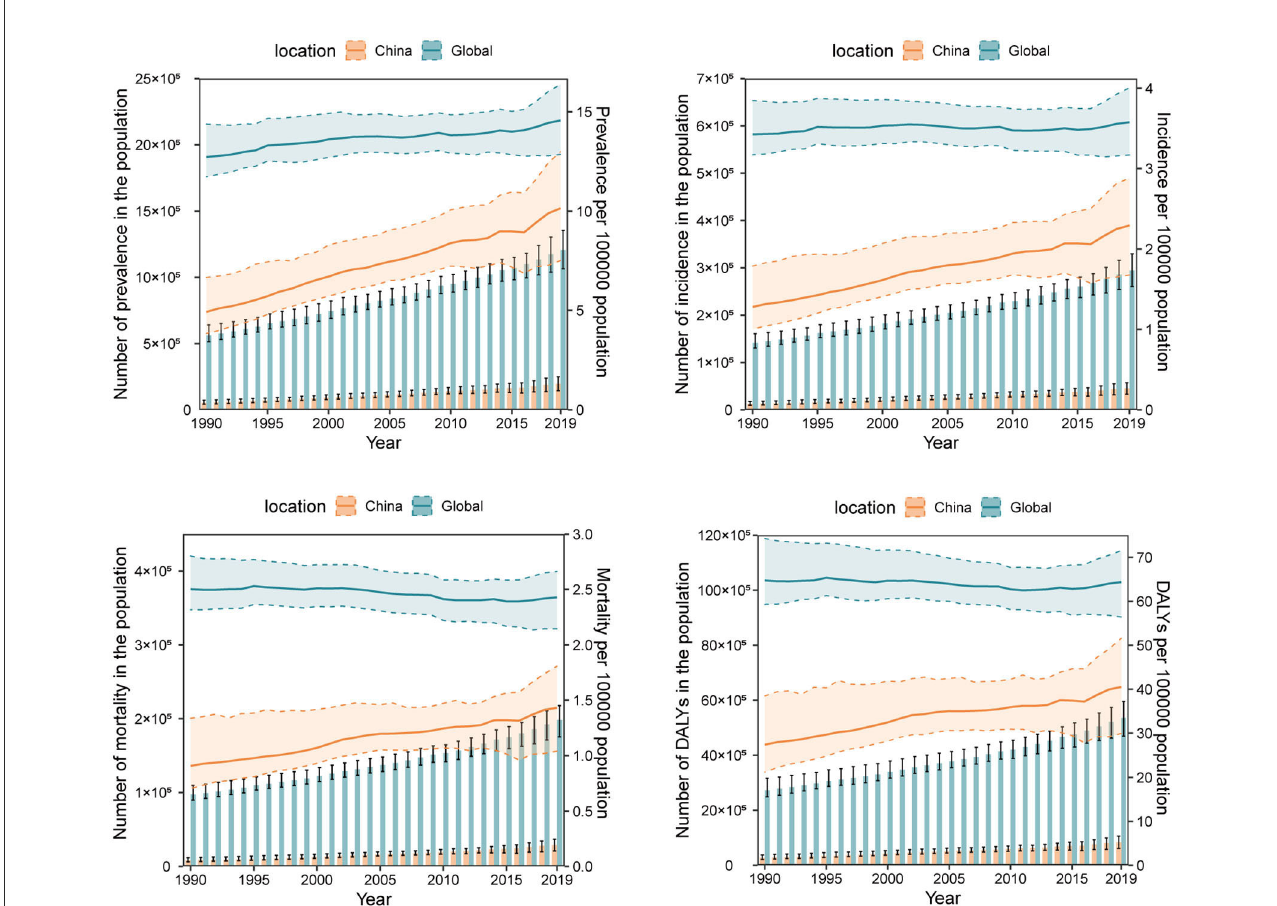
FIGURE1 The numbers and age-standardized rates (per 100,000 population) of ovarian cancer prevalence, incidence, mortality, and disability-adjusted life-years (DALYs) from 1990 to 2019 in China and the global level. The bar chart represents numbers and the broken line chart represents age-standardized rates.